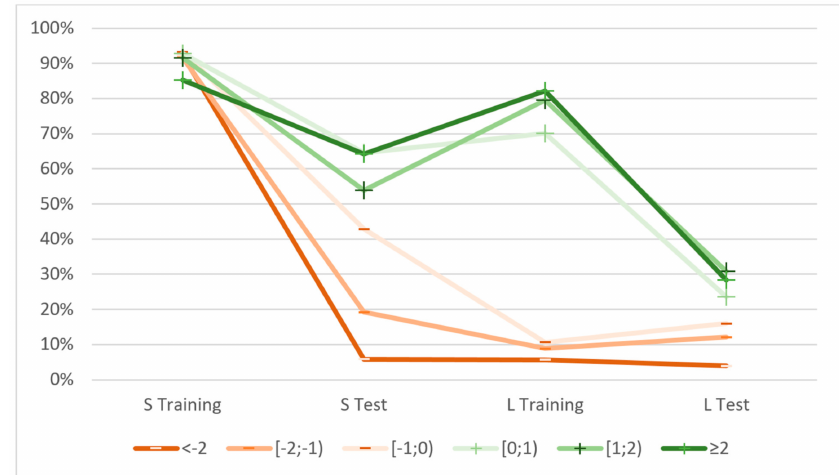
Figure 11. Percentage share of the number of buy signals from the best networks (based %MP and pNEP indicators) achieved for a given class of values. Note: S is the best network based on pNEP and L based on %MP indicator.